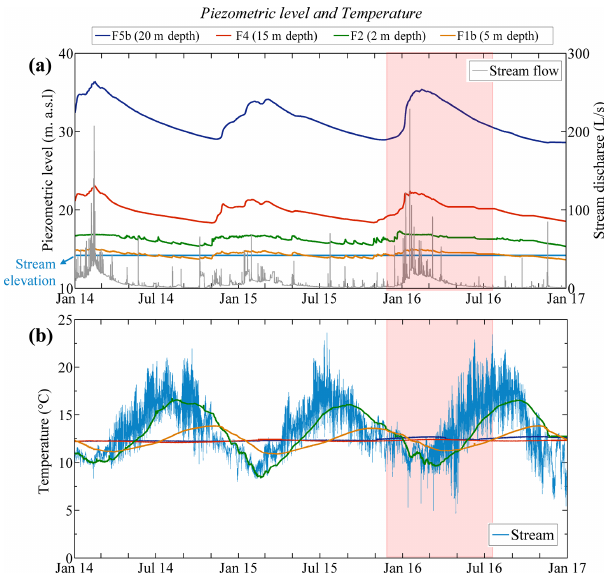
show clear seasonal fluctuations with high levels during win- ter and spring and low levels during summer and autumn.